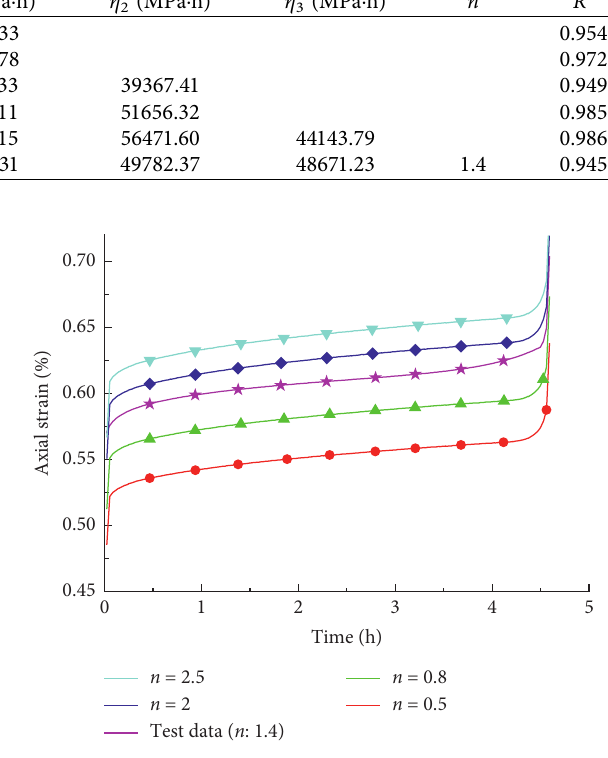
Table 6: Parameters of the improved Nishihara model for rock-concrete composite specimens under the confining pressure of 7 MPa. Axial stress (MPa)